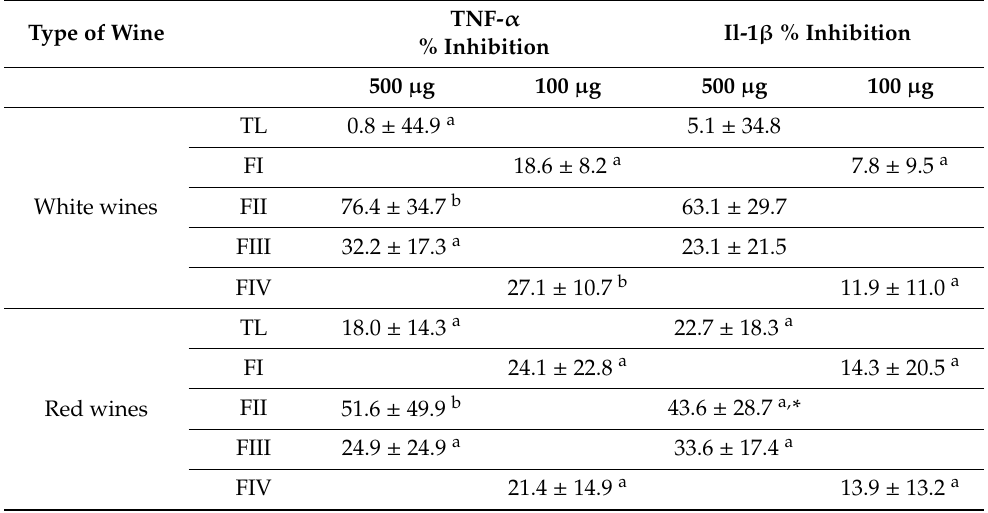
Table 4. Anti-inflammatory activity of wines per extract type and per wine